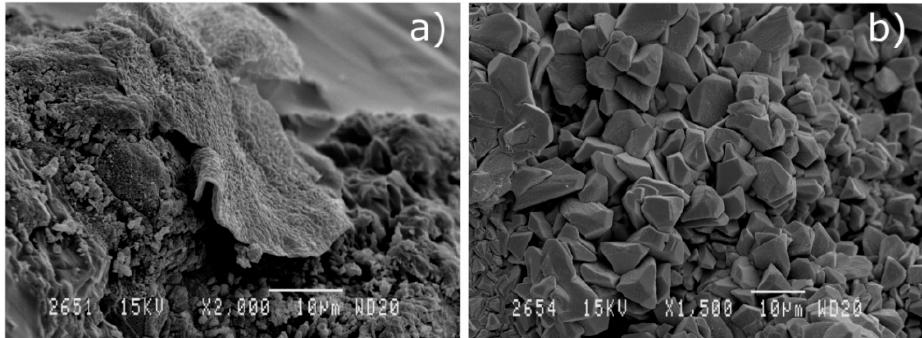
Figure 9. SEM micrographs of the concrete samples: ( a ) 31- SSA / FA / RHA and ( b ) 32- SSA / RHA , cured for 90 days.